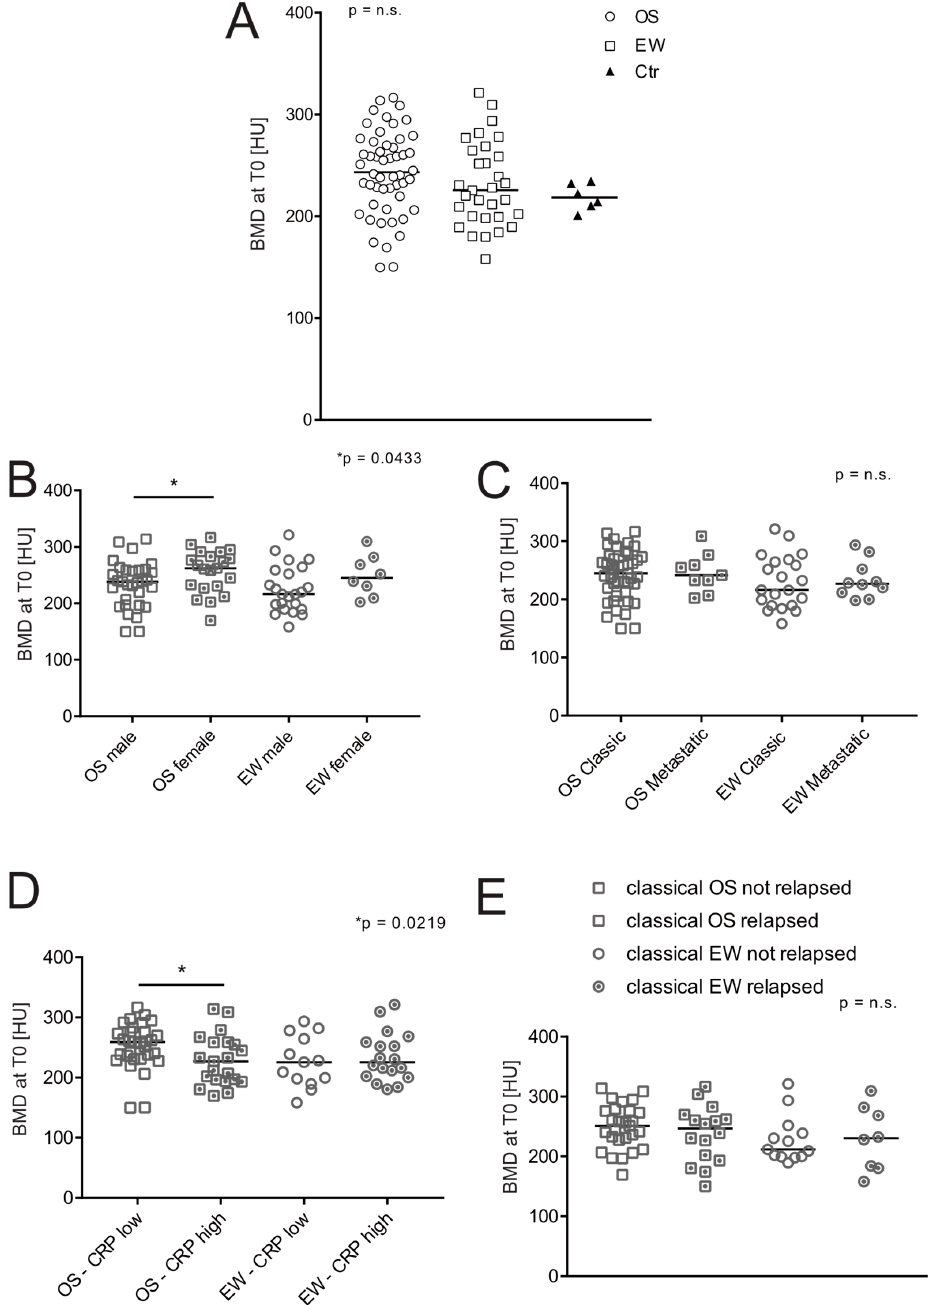
Figure 1. Effect of age, sex, and clinical features on BMD at the onset of patients with bone sarcoma. BMD was measured by ROI attenuation of T 12 vertebrae assessed by CT in OS ( n = 52), EW ( n = 31), and control group (Ctr, n = 6). ( A ) Values and median of BMD values at the onset; ( B ) values shown in panel A, divided by sex (Mann–Whitney U test, * p < 0.05); ( C ) BMD values shown in panel A, divided by the presence/absence of clinically relevant metastases at diagnosis (Mann–Whitney U test); ( D ) BMD values shown in panel A, divided by low/high CRP values (CRP high > 0.5 mg/100 mL, Mann–Whitney U test, * p < 0.05); ( E ) BMD values shown in panel A and divided by the presence of relapse at follow-up (Mann–Whitney U test).